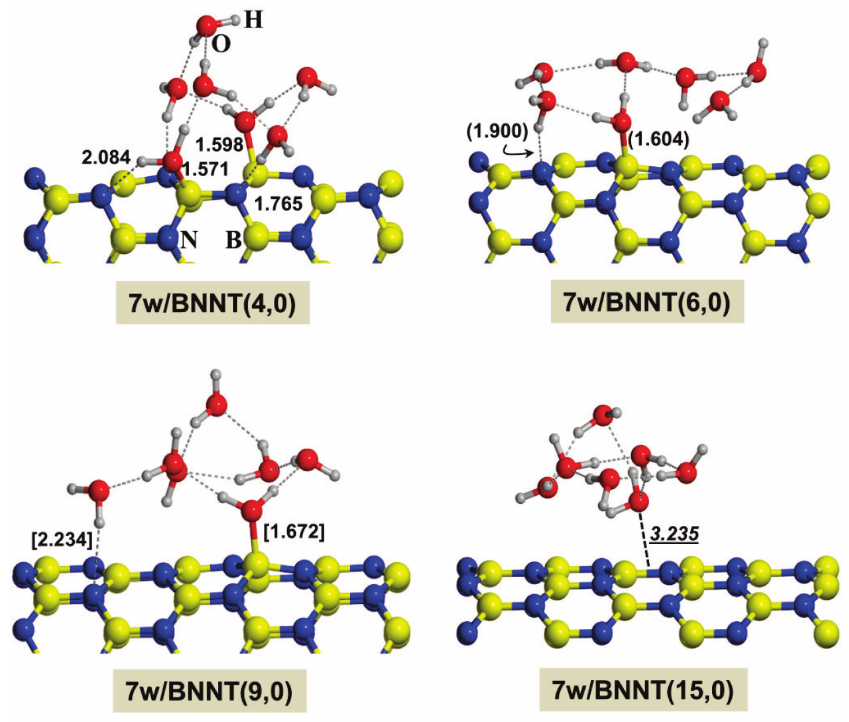
Figure 3. B3LYP-D2* optimized structures of the different calculated complexes for the considered BNNTs in the presence of seven water molecules. Distances in Å: bare values for the (4,0) BNNT; values in parenthesis for the (6,0) one; values in brackets for the (9,0) one; and italic underscored values for the (15,0) one. For this latter case, the distance is that between the closest water O to the plane defined by the B-N hexagon